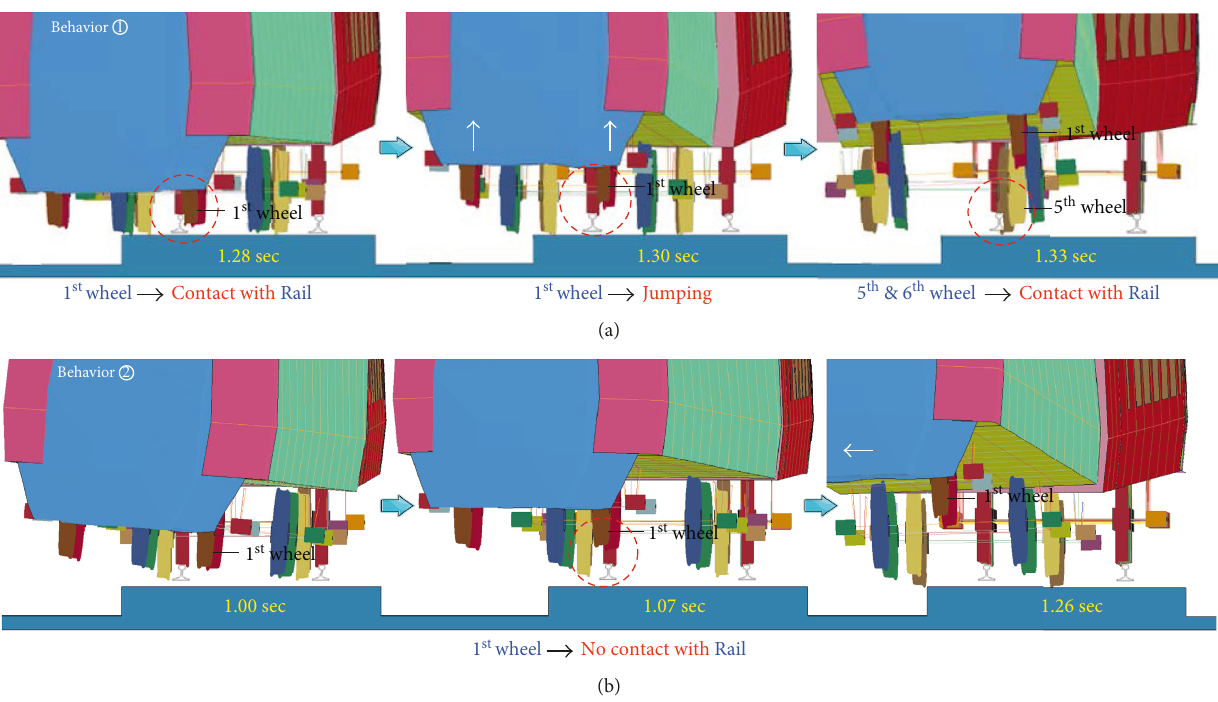
Figure 15: Derailment-collision behavior (distance effect 4). (a) Behavior 1. (b) Behavior